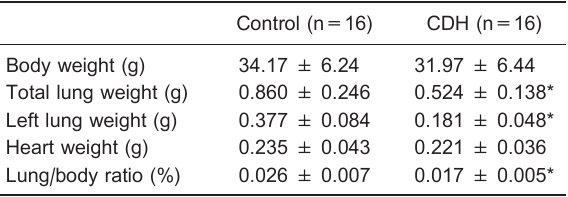
Table 1. Anatomical data of control and congenital diaphrag- matic hernia (CDH) groups. Control (n=16)